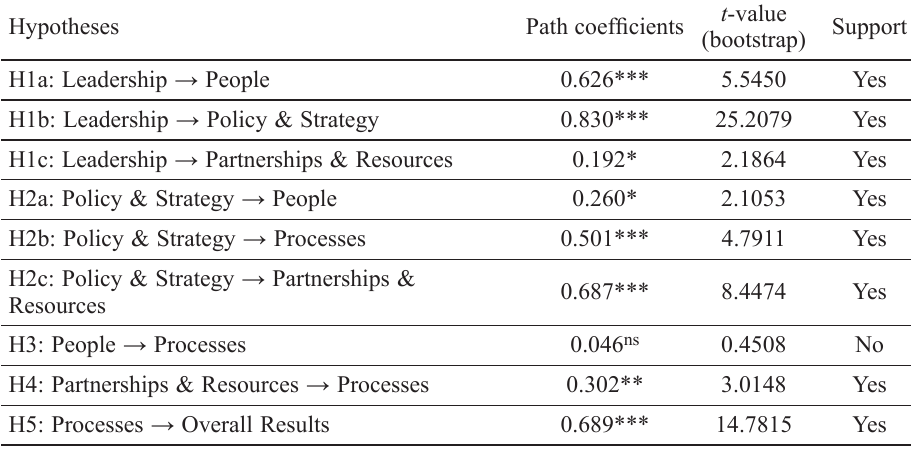
Table 4. Structural model results